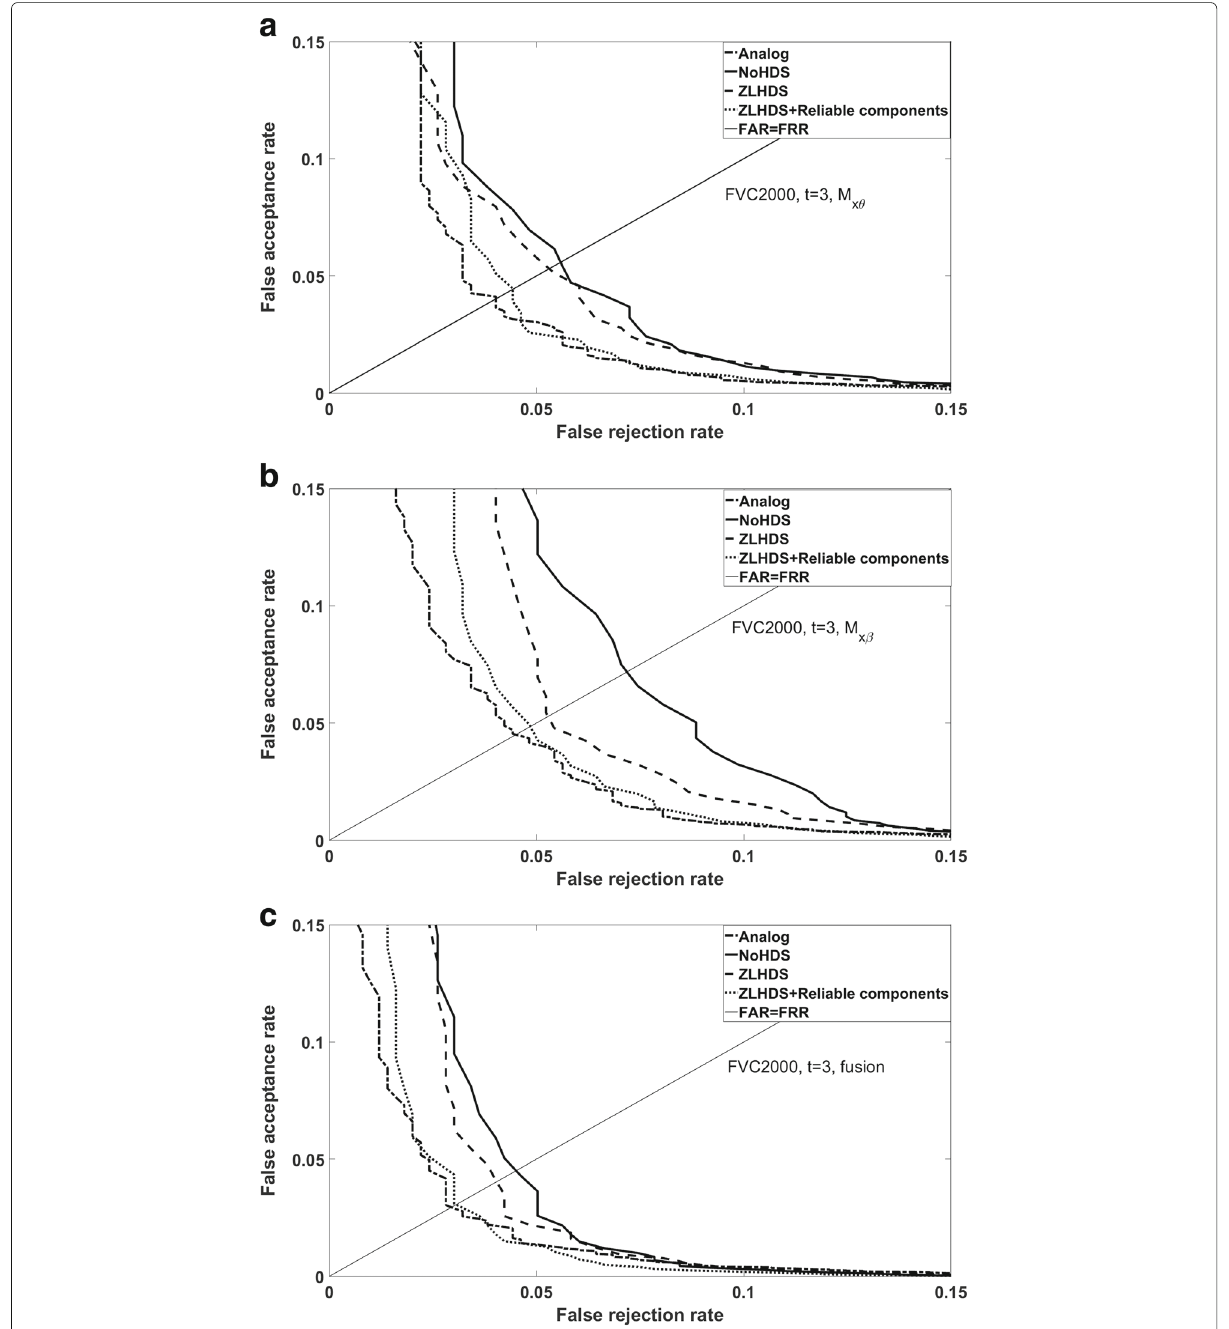
Fig. 9 Performance result for several processing methods. FVC2000. Enrollment method E2 with t = 3